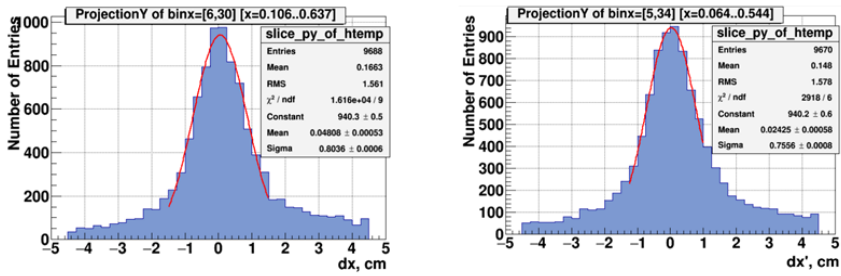
Figure 6. CSC X and Y hit residuals: magnetic field of 0.6